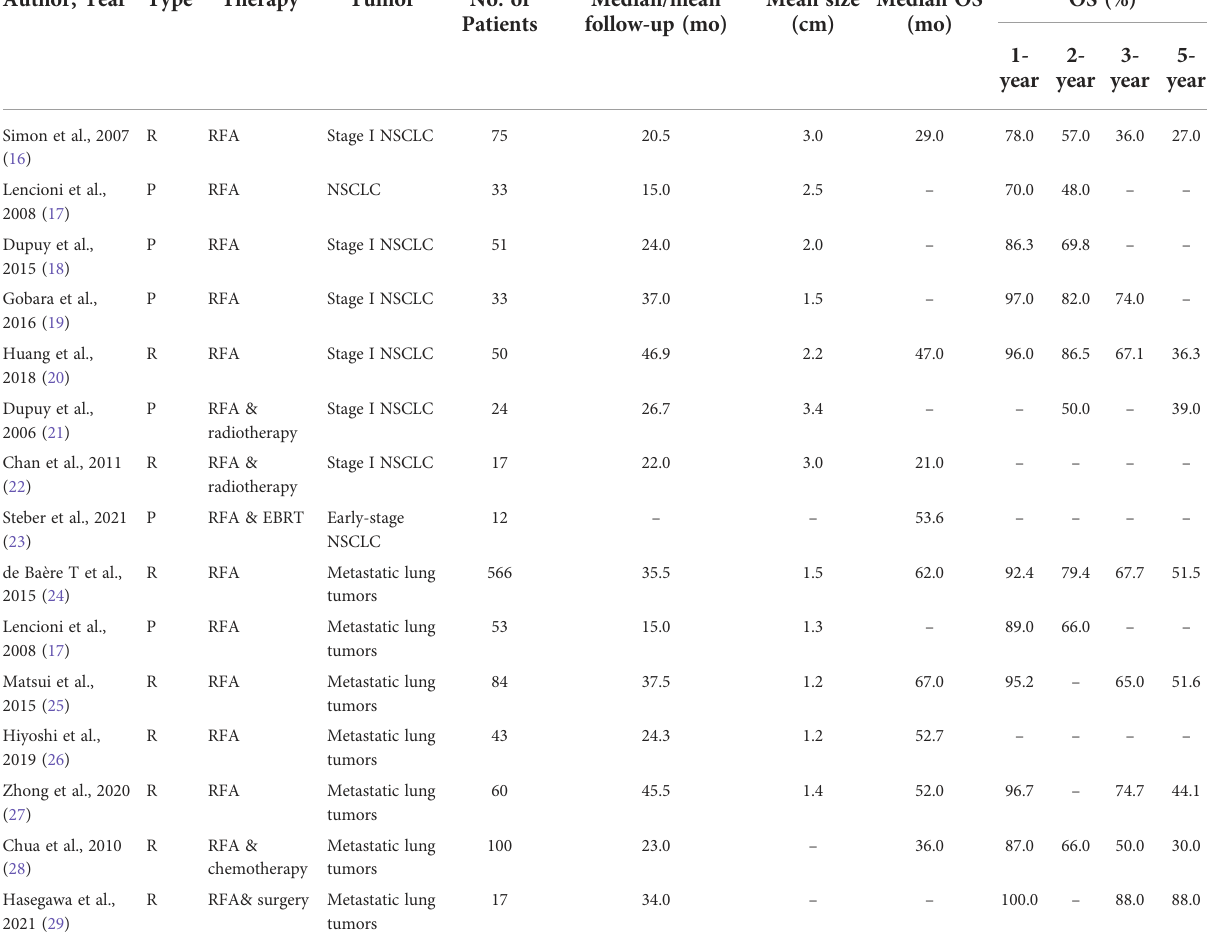
TABLE 1 Summary of published studies of RFA in lung